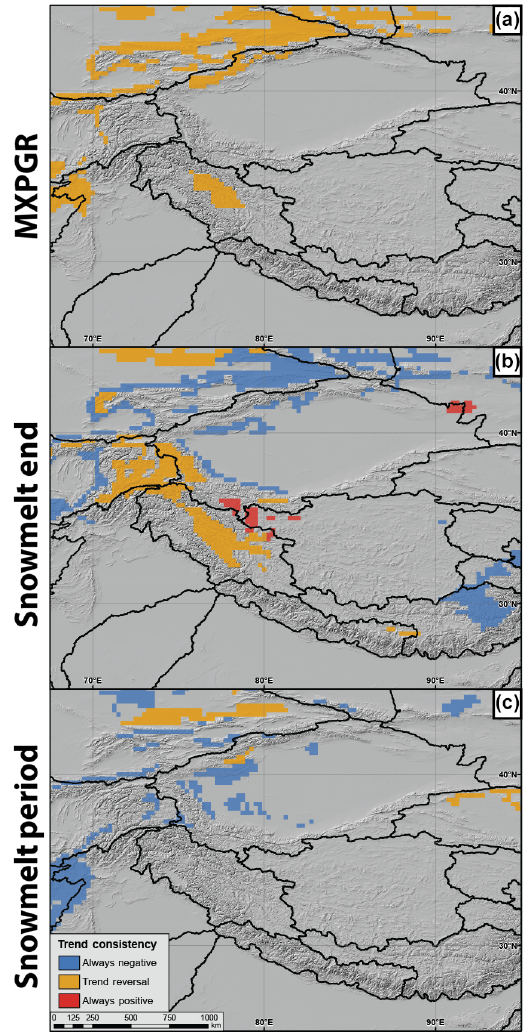
Figure 12. Impact of analysis period (1988–2002 or 2002–2016) on measured trends in (a) MXPGR, (b) snowmelt end, and (c) snowmelt period. Grey areas indicate lack of statistically sig- nificant ( p < 0 . 05) trends at one or both analysis periods. Much of HMA lacks significant shorter-term trends in MXPGR and snowmelt period, highlighting the complexities and interannual variation in the snowmelt season. While northern HMA has main- tained a negative trend in snowmelt end throughout both analysis time frames, a large region running eastward from the Pamir has had a reversed trend from negative to positive in the last decade. Regression results at both individual time frames are available in the Supplement (Fig.